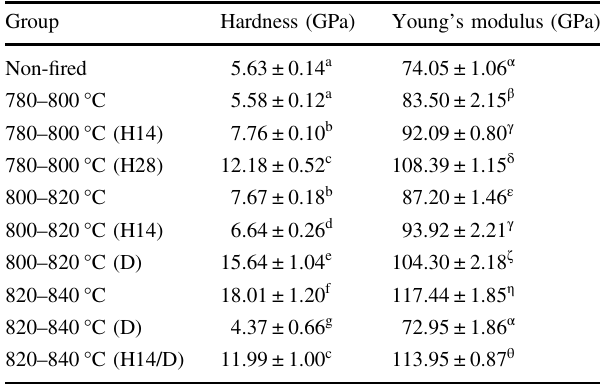
A 820 – 840 °C; B 800 – 820 °C; C 780 – 800 °C. The loading curve was related to elastic deformation of the contact, while the unloading curve was response to the elastic recovery of the contact. Group with longer displacffement indicated a weaker mechanical Table 2 Average values for hardness and Young ’ s modulus of LDGC materials under different heating conditions Group